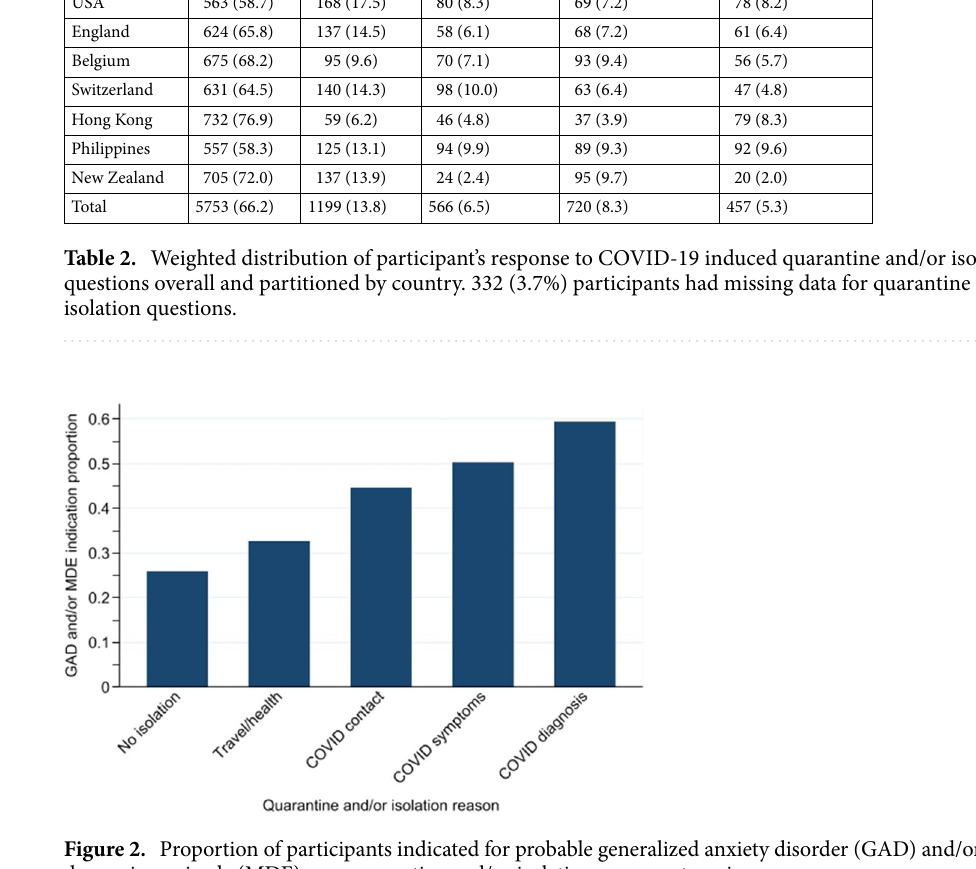
Figure 2. Proportion of participants indicated for probable generalized anxiety disorder (GAD) and/or major depression episode (MDE) over quarantine and/or isolation reason categories.